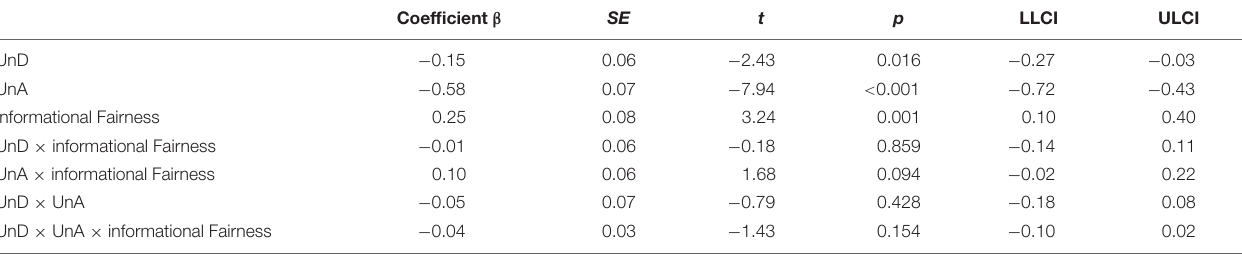
TABLE 6 | Effects of the moderated regression analysis including informational fairness (Hayes, 2013, Model 3).